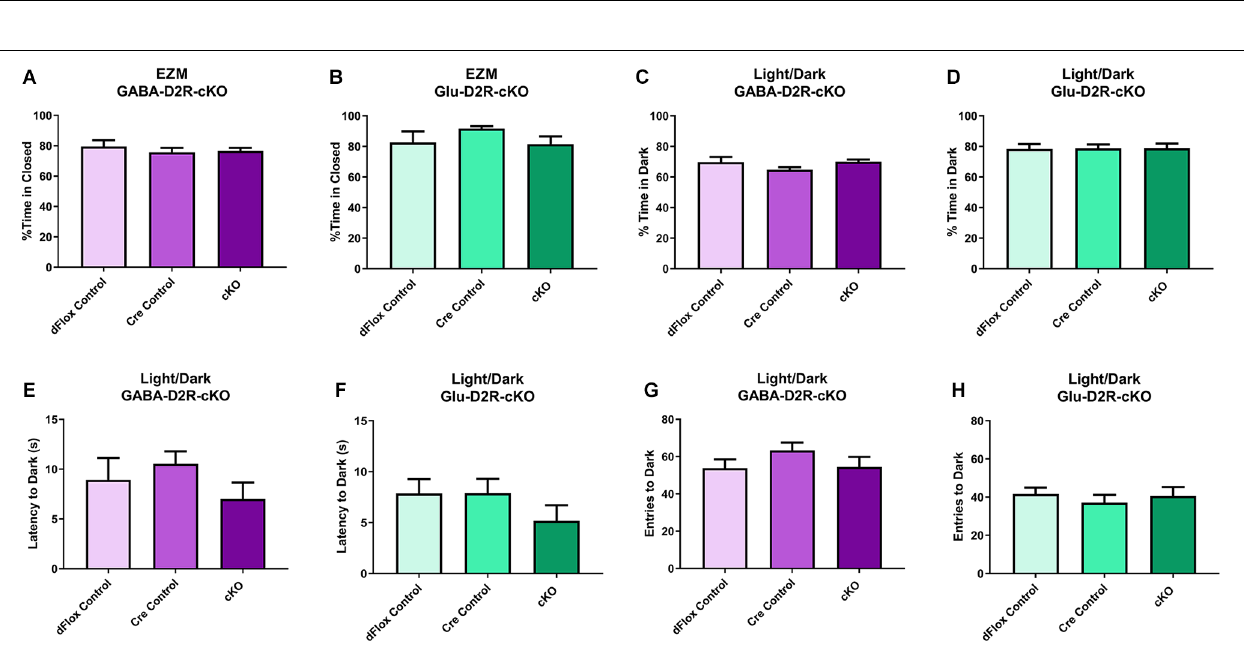
FIGURE 7 | No changes in anxiety-like behavior in GABA-D2R-cKO and Glu-D2R-cKO mice. GABA-D2R-cKO (A,C,E,G) and Glu-D2R-cKO (B,D,F,H) mice did not differ in anxiety measurements, as measured by the EZM (A,B) and light/dark test (C–H) . N = 9–13/group.